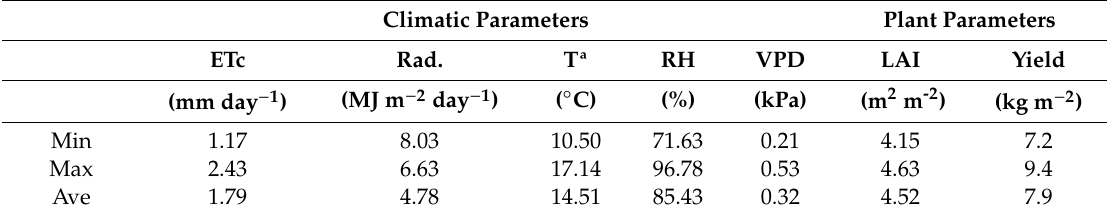
Table 1. Average, maximum, and minimum values of the climatic parameters (crop evapotranspiration